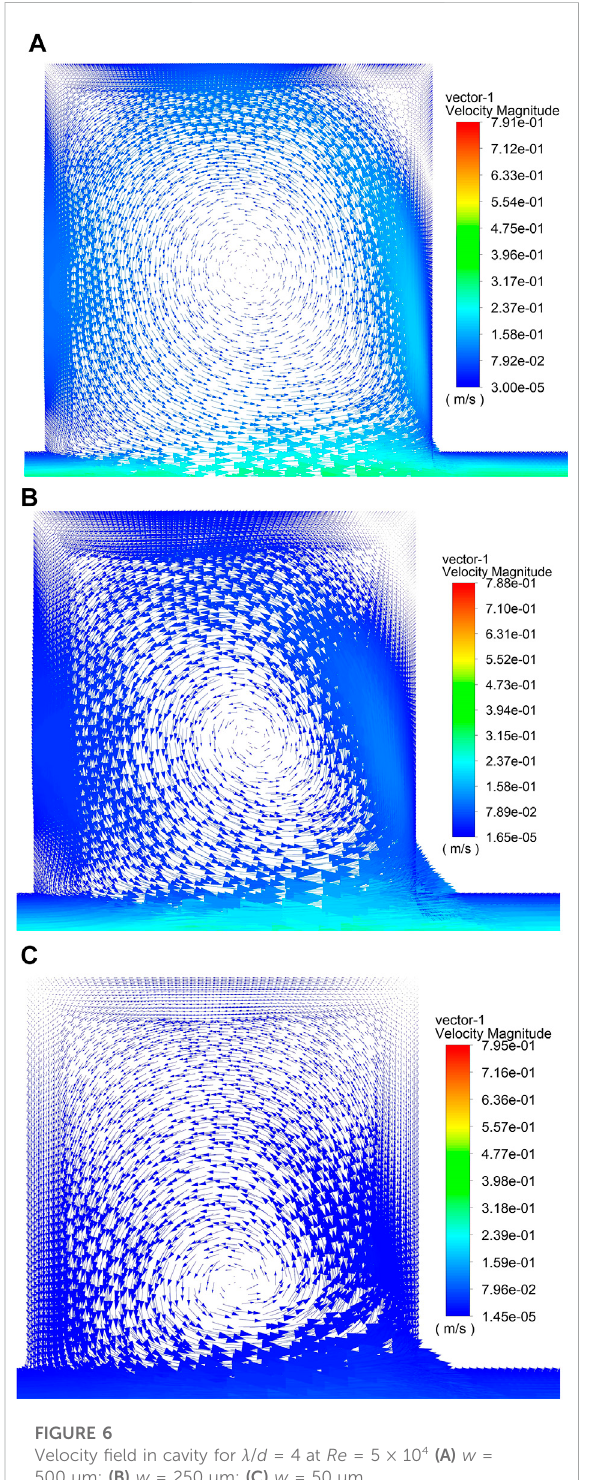
Figure 6 gives the fl ow velocity fi elds in cavities under different roughness at Re = 5 × 10 4 and Figure 7 gives the corresponding iron concentration distributions. Given the same inlet condition, the